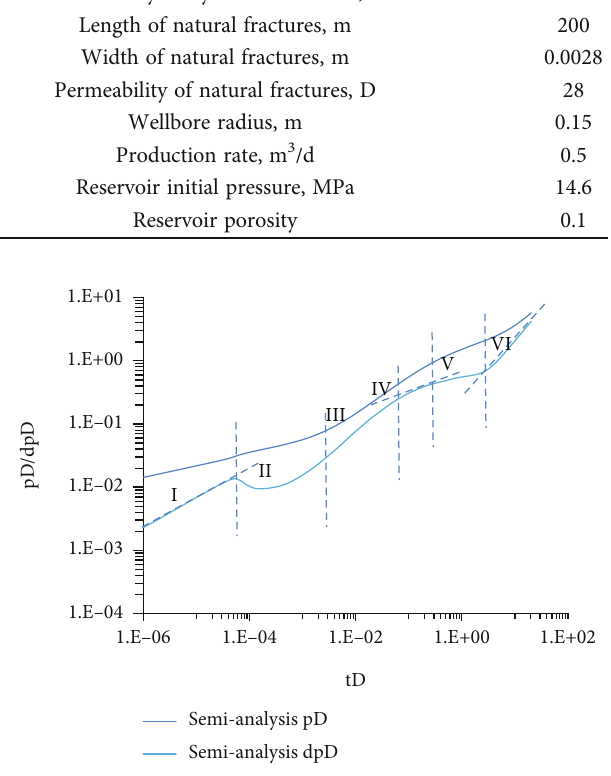
Figure 6: Flow regimes of the complex fracture